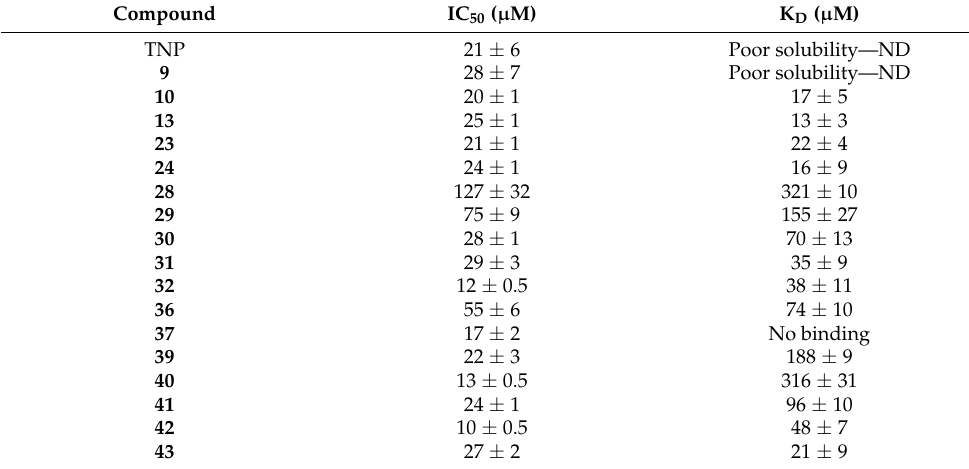
Table 7. Summary to the binding affinities (K D ) of TNP and its analogues to Cn Arg1 as determined by surface plasmon resonance (SPR). Analogue binding to N-terminally biotinylated Cn Arg1 im- mobilised onto a streptavidin chip was assessed between 6.25–200 µ M at 10 ◦ C in 20 mM HEPES, 150 mM NaCl, pH 7.5. The IC 50 and K D values are presented as mean ± SEM (IC 50 — n ≥ 3 technical replicates; K D — n ≥ 1). ND = not